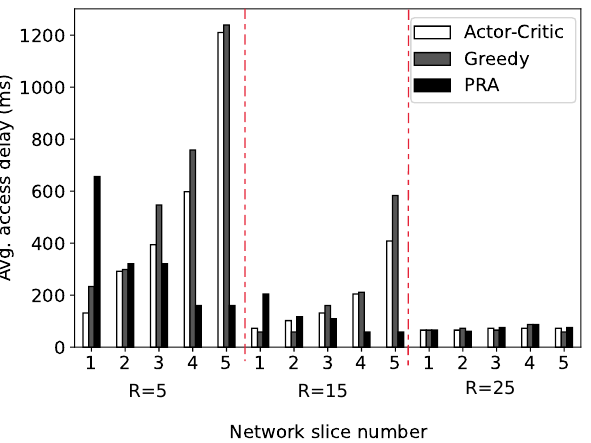
Figure 8. Performance comparison with benchmark algorithms in terms of average access delay. Slice 1 is delay-sensitive, while Slice 5 is